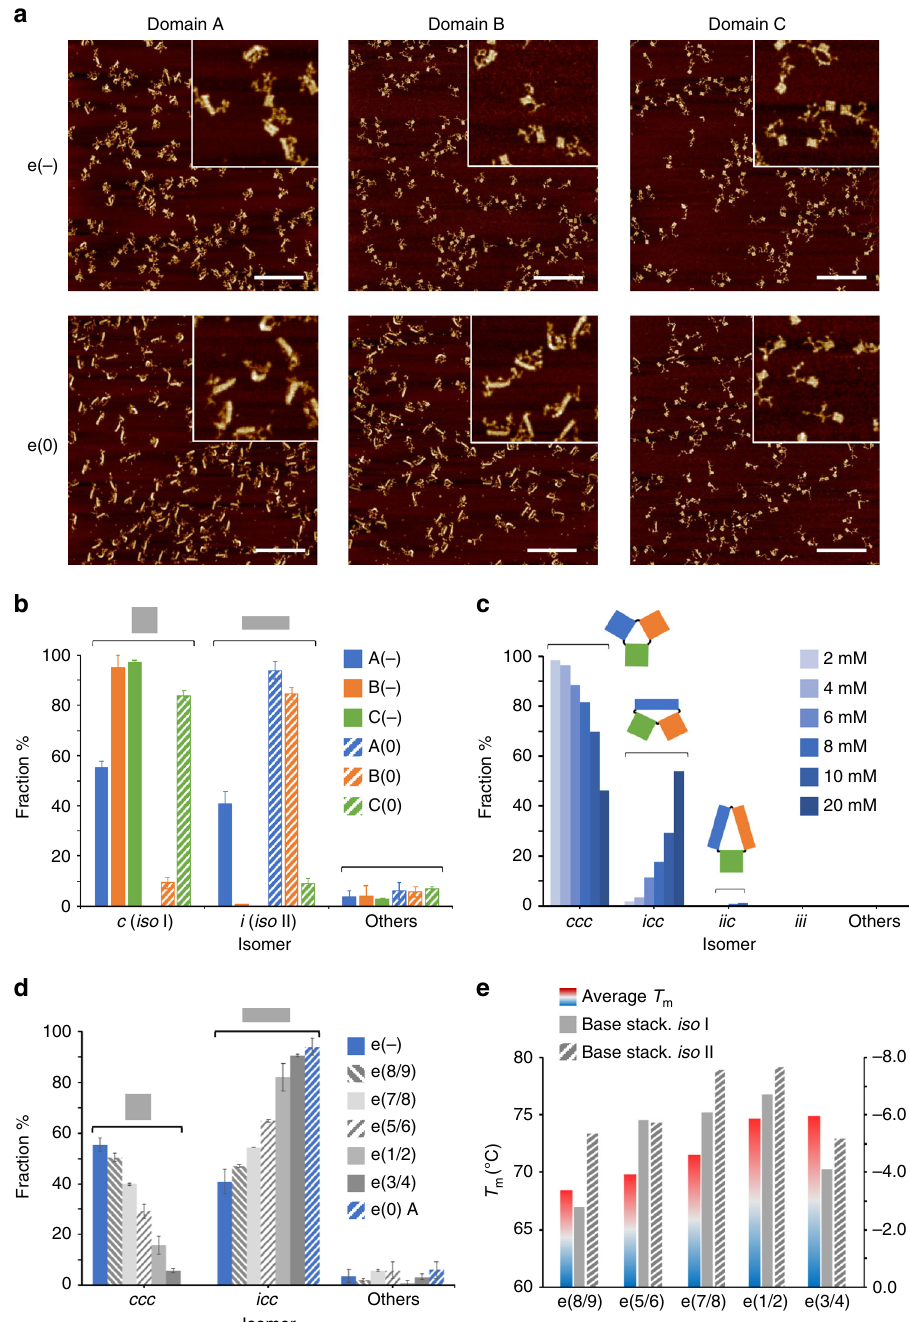
Fig. 3 Sequence-dependent contributions to the folding of a DNA origami. a Representative AFM images and b statistical analysis of the end products obtained by assembling each individual domain either in the absence or presence of edge staples of type 0 (e( − ) and e(0) constructs, respectively indicated by full and striped colored bars in blue, orange and green, for domain A, B, and C). Scale bars of the AFM images are 600 nm. Insets are 1 μ m × 1 μ m. c Effect of Mg 2 + ions concentration on the distribution of the end products, indicating a bias for the iso II form of domain A enhanced by increasing magnesium concentrations. d Statistical analysis of the end products obtained by assembling domain A in the e( − ) design in presence of distinct pairs of e(0) staples (indicated as 1/2, 3/4, 5/6, 7/8 and 8/9), targeting consecutive scaffold turns on the left-side of the structure. e Thermal stabilities (colored bars) and base stacking energies of the e(0) staple pairs of domain A in both the iso I and iso II conformation (full and striped gray bars). Note the good correlation between the average T m of the staples and the degree of isomerization induced (d). A poor match results instead by the calculated base stacking contributions. Error bars were obtained from three independent images of the same sample, each showing several hundreds of individual structures. Source data are provided as a Source Data fi